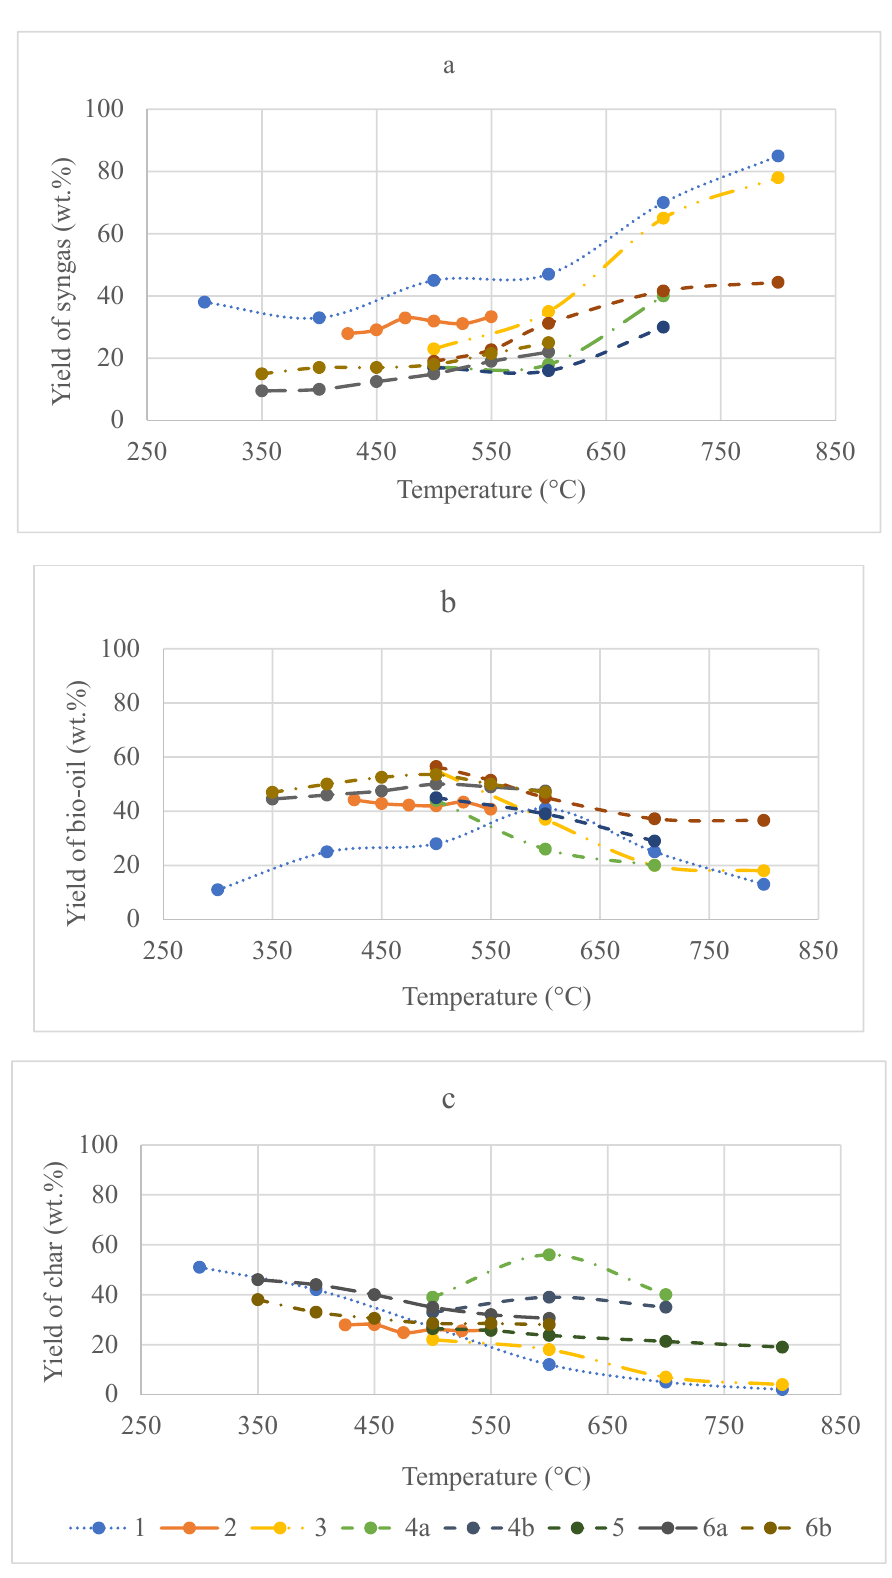
Figure 3. Effects of pyrolysis temperature on the yield of pyrolytic fractions: ( a ) non-condensable fraction, ( b ) condensable fraction, ( c ) residual char: (1) Anaerobically digested sewage sludge [78], (2) Milkweed [79], (3) Legume straw [80], (4a) Corn cob and (4b) Corn stalk [81], (5) Pine woodchips [82], (6a) Rice husk and (6b) Corn stalk [83].